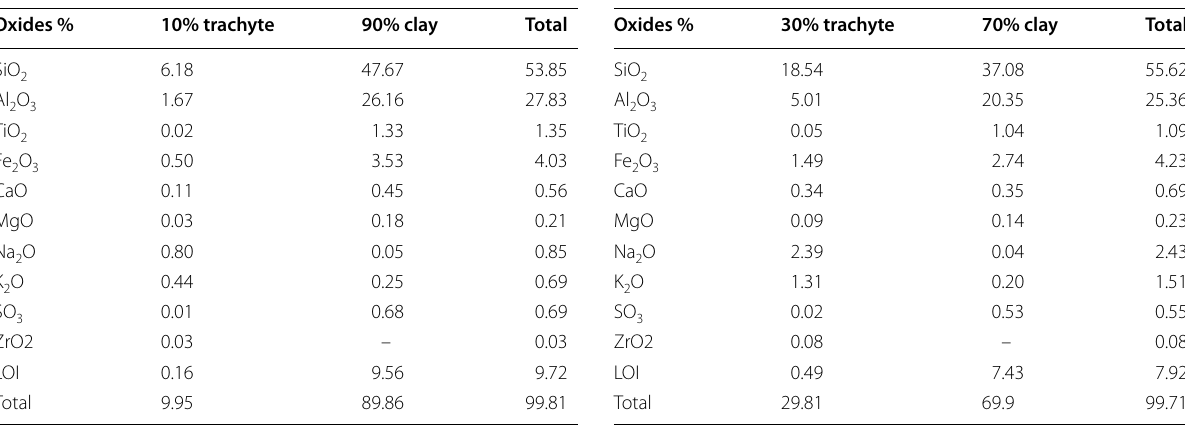
Table 2 Chemical composition of the design batch no. 1